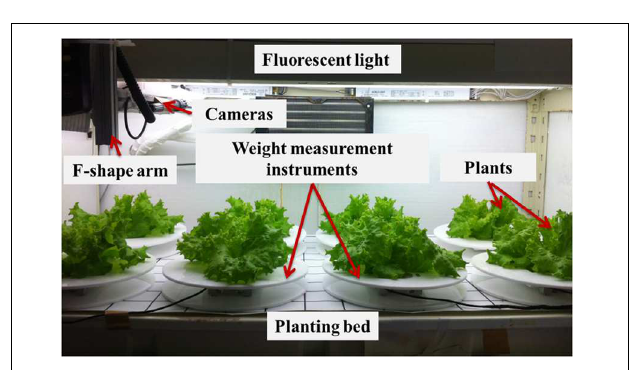
FIGURE 3 | Real scene in National Taiwan University plant factory.